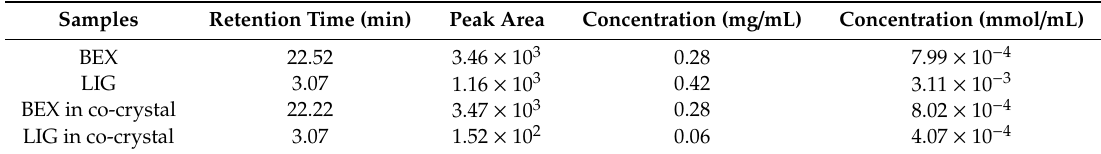
Figure 4. Characterization of 2bexarotene-ligustrazine (2BEX-LIG): ( a ) Powder X-ray di ff raction (PXRD) patterns of experimental and calculated 2BEX-LIG, products of original chemicals in 1:1 and 2:1, BEX, and LIG; ( b ) Di ff erential Scanning Calorimeter (DSC) patterns of BEX (black), LIG (blue), and 2BEX-LIG (red); ( c ) PXRD patterns of 2BEX-LIG in high humidity, illumination, high temperature, and pure co-crystal performed with the same method as in ( a ); and ( d ) Thermogravimetric Analysis (TGA) pattern of 2BEX-LIG. Table 3. Data of HPLC